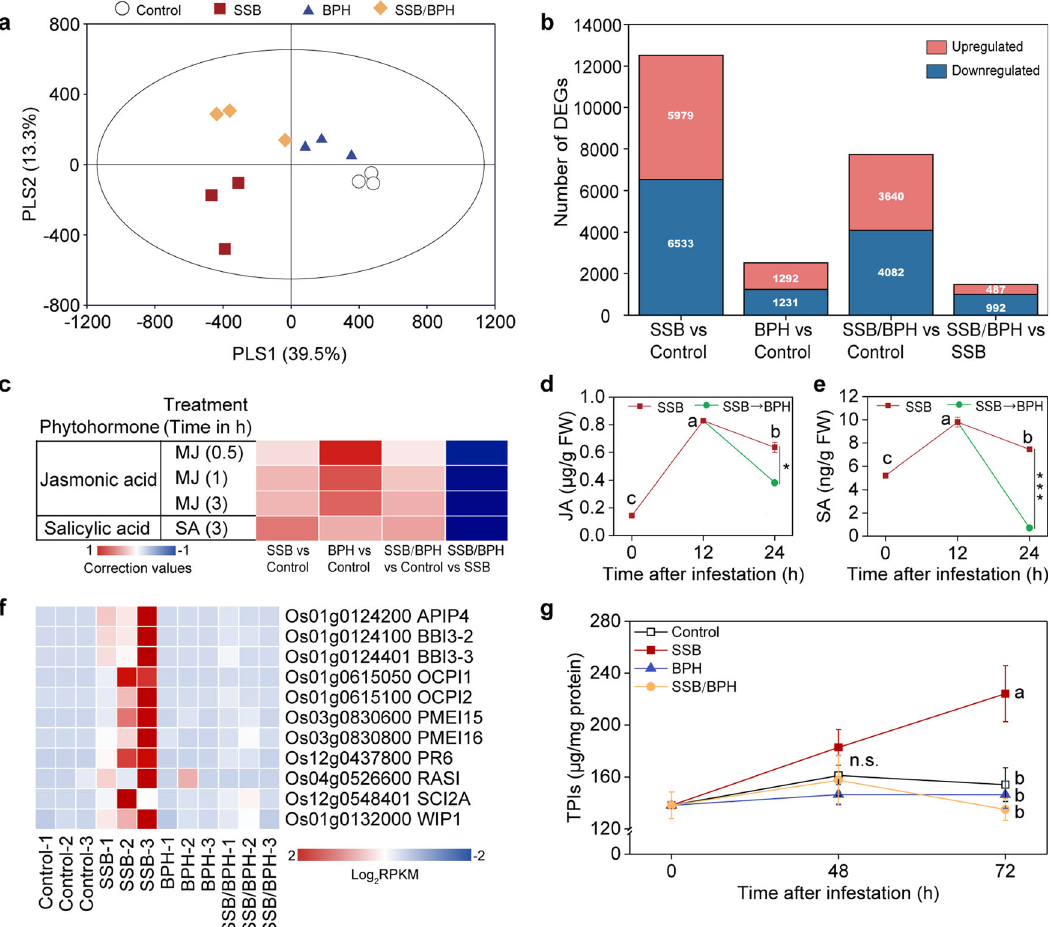
Fig. 4 Rice plant responses to herbivore infestation. a Partial least squares-discriminant analysis (PLS-DA) of all detected genes in rice plants that were either untreated (control), infested by SSB, BPH, or both herbivores (SSB + BPH) for 48 h (three biological replicates per treatment). The percentage of variation of the data explained by principal component 1 (PLS1) and PLS2 is in parentheses (39.5 and 13.3%, respectively). The score plot displays the grouping pattern according to the fi rst two components and the ellipse de fi nes the Hotelling ’ s T2 con fi dence interval (95%) for the observations. b Differentially expressed genes among differently treated rice plants. c Hormonometer analyses for jasmonic acid (JA) and salicylic acid (SA) signatures based on transcriptomic responses of rice to herbivory. The colors indicate similarity between herbivore infestation and a particular hormone response (blue and red for negative and positive correlations, respectively, see bottom). MJ methyl jasmonate, SA salicylic acid. The contents of endogenous JA ( d ) and SA ( e ) in rice plants subjected to SSB infestation or SSB plus BPH in sequence. Signi fi cance was determined by one-way ANOVA followed by Tukey ’ s honest signi fi cant difference (HSD) test (for three groups) or two-sided Student ’ s t -test (for two groups). For JA contents, exact P- values = 1.79e- 06 (0 h vs 12 h), 1.18e-05 (0 h vs 24 h), 0.0022 (12 h vs 24 h), 0.020 (SSB 24 h vs SSB/BPH 24 h); for SA contents, exact P -values = 8.05e-05 (0 h vs. 12 h), 0.0040 (0 h vs 24 h), 0.0032 (12 h vs 24 h), and 1.68e-06 (SSB 24 h vs SSB/BPH 24 h) ( n = 3). Different letters indicate signi fi cant differences within the SSB treatment at different time points ( P < 0.05); asterisks indicate signi fi cant differences between SSB and SSB → BPH treatments (*** P < 0.001, * P < 0.05) ( n = 3). Bars indicate mean ± SE. f Heatmap of the expression of 11 enzyme inhibitors genes. Log 2 -transformed RPKM values are plotted. APIP4 bowman-birk inhibitor AvrPiz-t interacting protein 4, BBI3-2 bowman-birk inhibitor 3-2, BBI3-3 bowman-birk inhibitor 3-3, OCPI1 Oryza sativa chymotrypsin inhibitor-like 1, OCPI2 Oryza sativa chymotrypsin inhibitor-like 2, PMEI 15 pectin methylesterase inhibitors 15, PMEI 16 pectin methylesterase inhibitors 16, PR6 pathogenesis-related proteins 6, RASI rice alpha-amylase/subtilisin inhibitor, SCI2A subtilisin-chymotrypsin inhibitor-2A, WIP1 wound-induced protease inhibitor 1. FPKM fragments per kilobase of transcript per million fragments mapped. g Time course of the contents of trypsin protease inhibitors (TPIs) in rice plants that were either uninfested (Control), infested by SSB, BPH, or both ( n = 3). For 48 h, exact P- values = 0.73 (Control vs SSB), 0.89 (Control vs BPH), 0.10 (Control vs SSB/BPH), 0.36 (SSB vs BPH), 0.63 (SSB vs SSB/BPH), and 0.95 (BPH vs SSB/BPH).; for 72 h, exact P -values = 0.034 (Control vs SSB), 0.98 (Control vs BPH), 0.78 (Control vs SSB/BPH), 0.020 (SSB vs BPH), 0.0096 (SSB vs SSB/BPH), and 0.94 (BPH vs SSB/BPH). Bars indicate mean ± SE. Data were analyzed using one-way ANOVA followed by Tukey ’ s post-hoc test. Different letters indicate signi fi cant differences between treatments ( P < 0.05). n.s. not signi fi cant ( P >